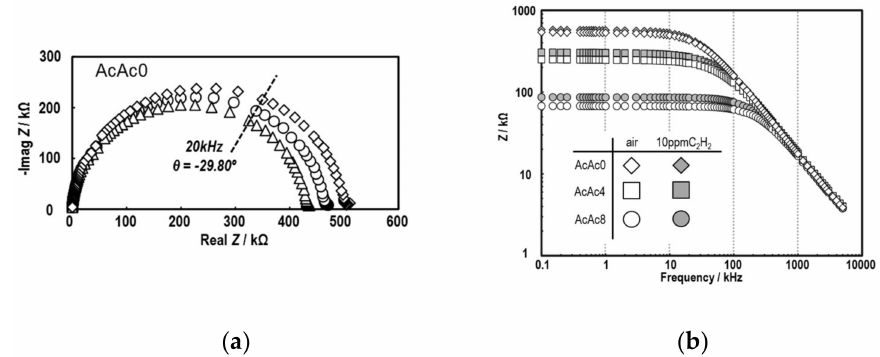
Figure 7. Nyquist plot in air ( a ) and Bode diagram in air and 10 ppm C 2 H 2 ( b ) of the SmFeO 3 device prepared from AcAc0, 4 and 8 precursors at 400 ◦ C.